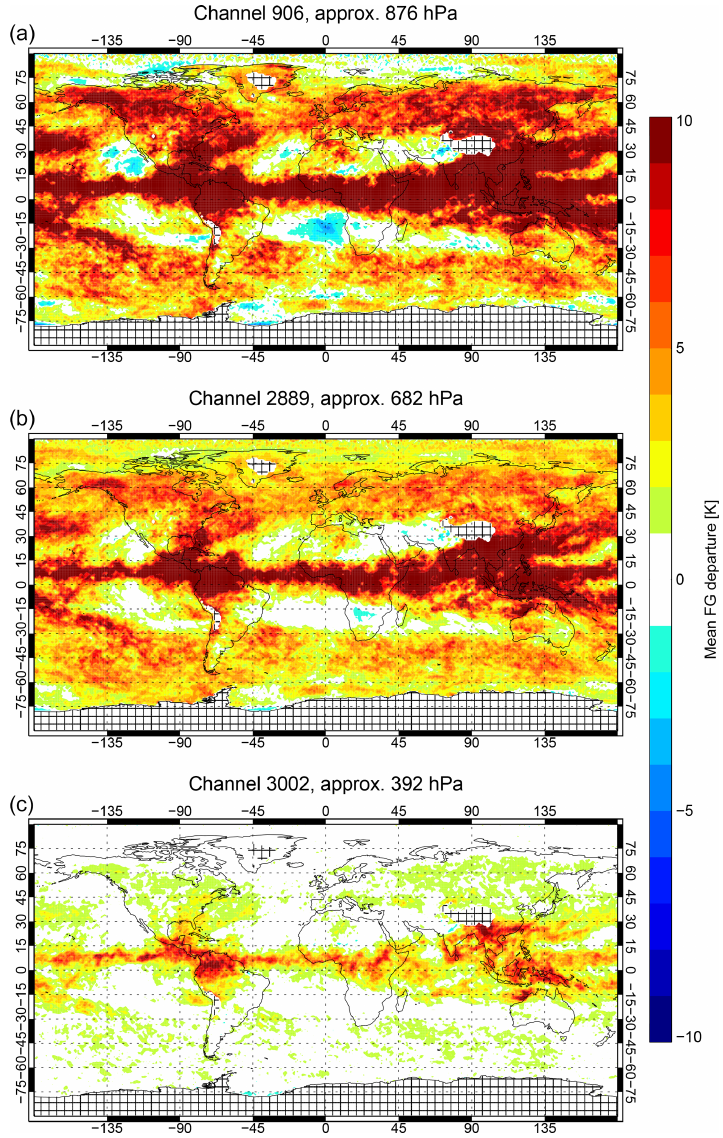
Figure 10. Mean all-sky background departures, as in Fig. 7 but using the CMSS cloud overlap. To retain the same colour bar as the other figure, many biases have been allowed to go off